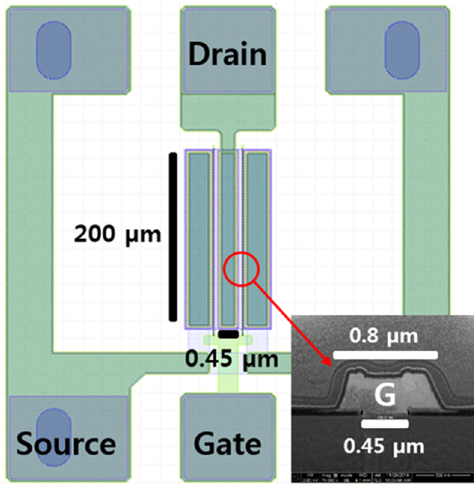
Figure 1. Top-view schematic of the two-finger basic AlGaN/GaN high electron mobility transistor (HEMT) structure and the cross-sectional scanning electron microscope (SEM) image of the one-finger gate electrode.